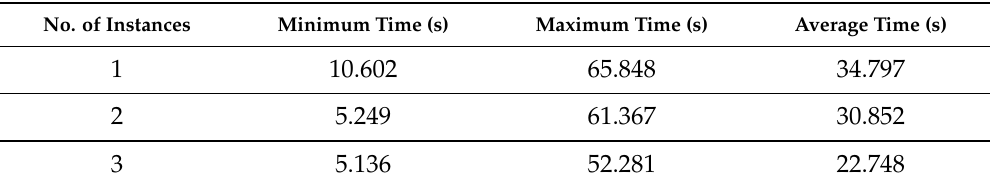
Table 3. (The results of Experiment 2.2): the response time (in seconds) handling concurrent requests over multiple deployed instances of the SEMi core.